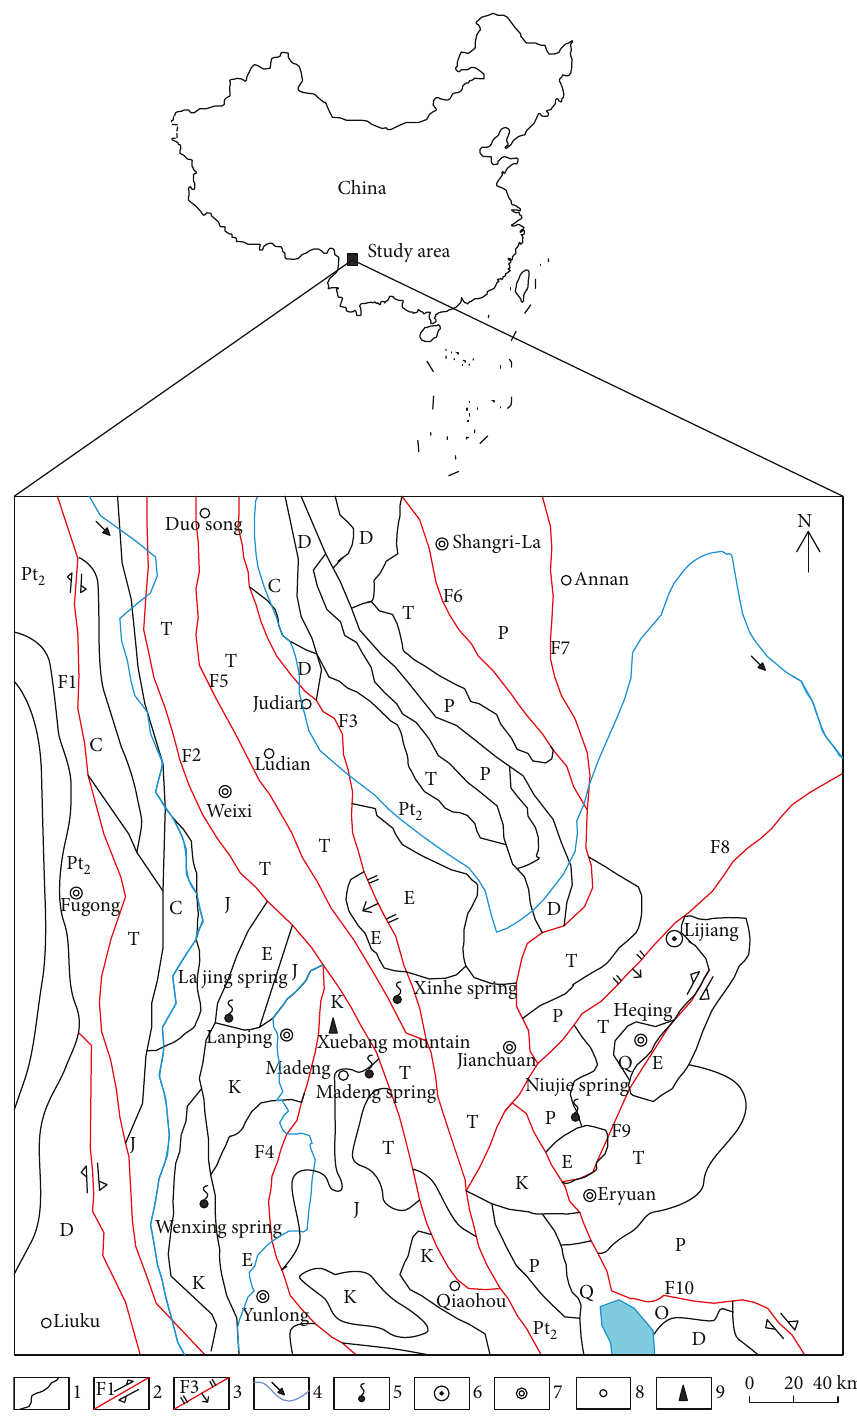
Figure 1: Geological sketch map near the Madeng hot spring in Jianchuan of Yunnan Q — Quaternary gravel and sand; E — Eogene purple mudstone, siltstone, sandstone, and conglomerate; K — Cretaceous fi ne-grained sandstone, amaranth mudstone, and feldspar quartz sandstone; J — Jurassic red mudstone, siltstone; T — Triassic limestone, siltstone; P — Permian basalt and tu ff breccia; C — Carboniferous quartz sandstone, limestone; D — Devonian dolomitic limestone and dolomite; O — Ordovician quartz sandstone; Pt